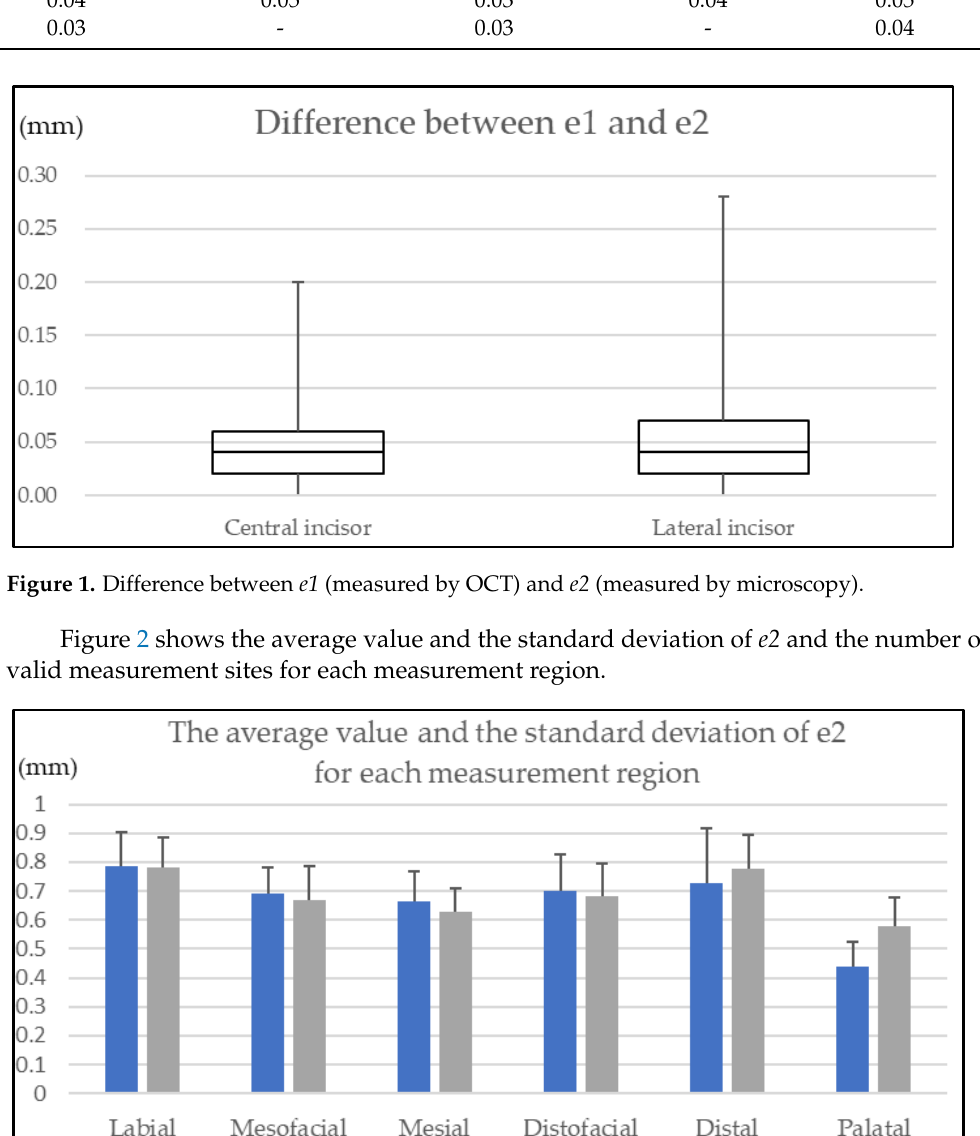
Figure 2. The average value and the standard deviation of e2 (measured by microscopy) for each measurement region .